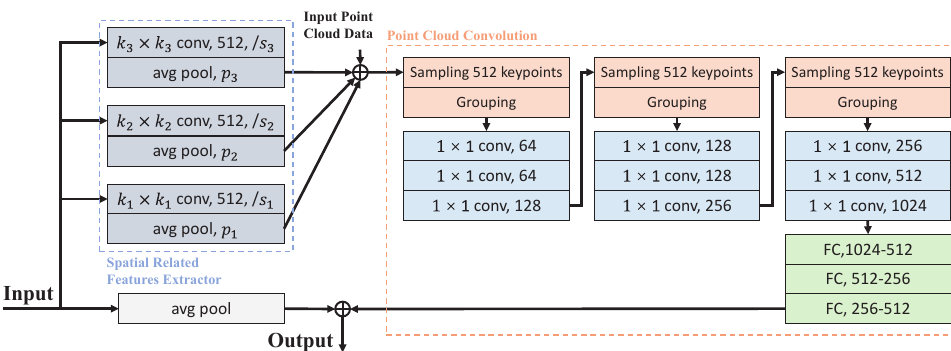
Figure 4. The structure of the 3D Prior Information Fusion Module. k × k conv , n , / s means the convolution layer with the kernel size of k, the kernel number of n, and the stride of s, while p means the pooling layer with a stride of p. FC , n 1 − n 2 means the input and the output of the connection layer are n 1 and n 2 ,